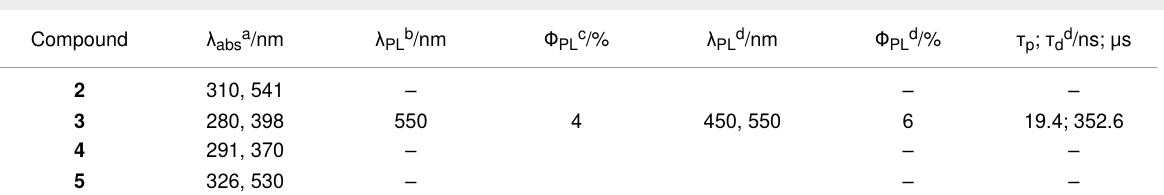
Table 2: Optoelectronic properties of 2 – 5 .